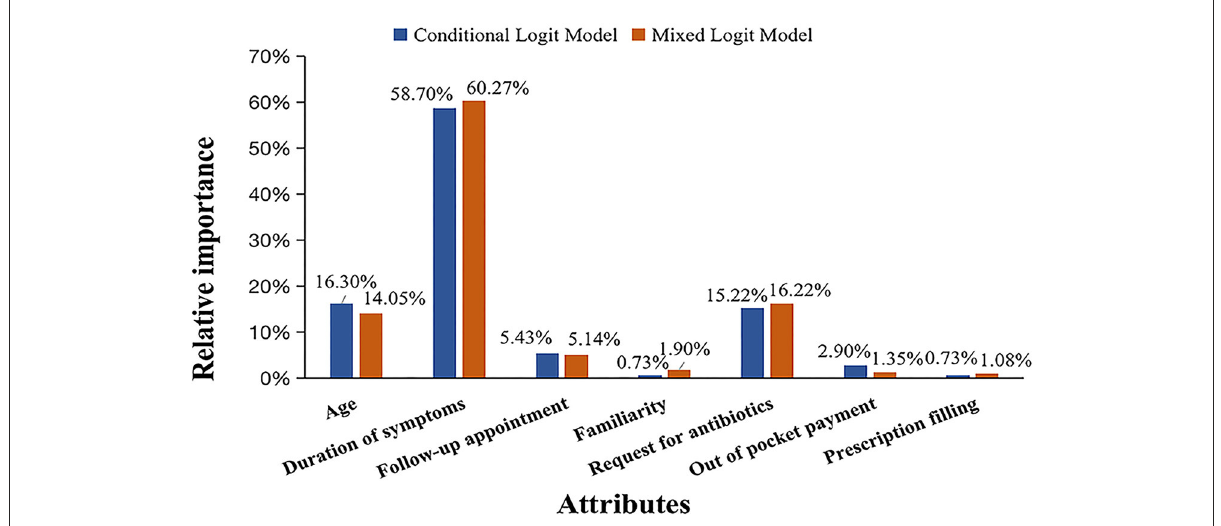
FIGURE2 Relative importance of the tested attributes in conditional logit and mixed logit models.